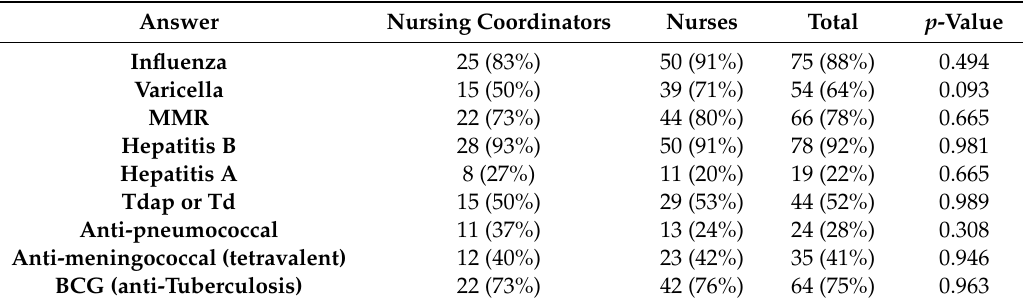
Table 4. Frequency distribution (values and percentages) and p -value (Yates’s chi-squared test) of